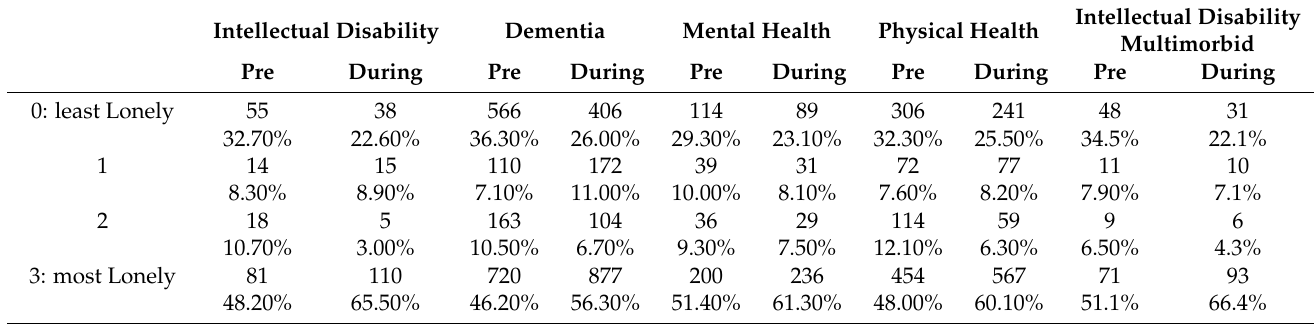
Table A2. Pre- and post-COVID-19 deJong social loneliness by Carer